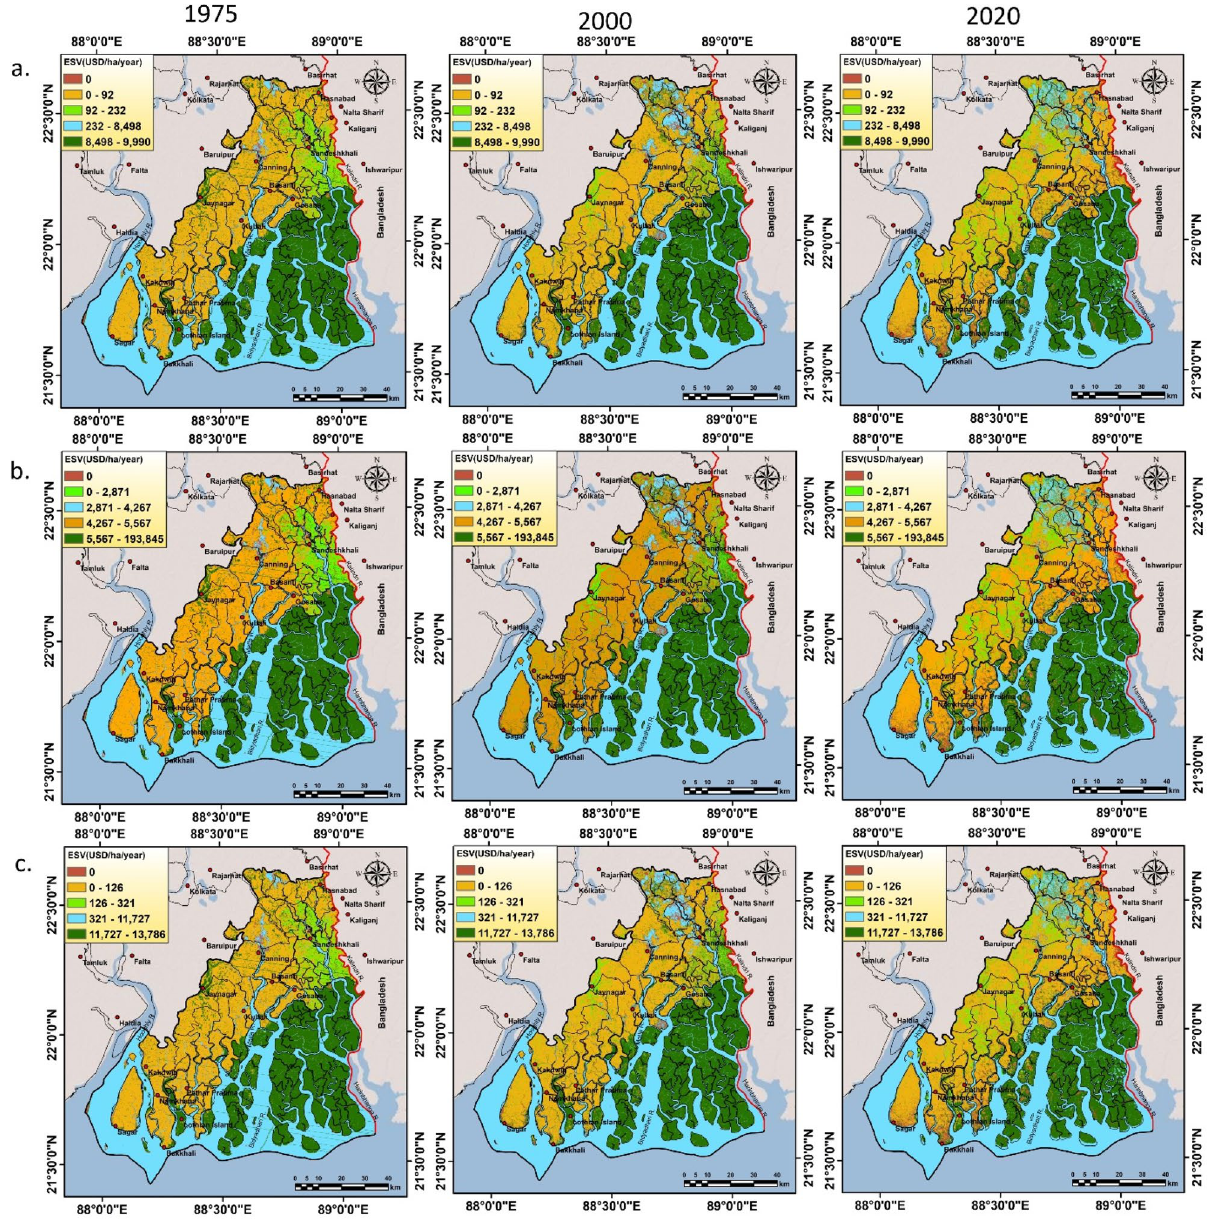
Figure 4. Spatial ordination of ecosystem service values (ESVs) (USD/ha/year) in 1975, 2000 and 2020 within the entire study region using ( a ). C97a ( b ). D12 ( c ). C97b unit values. The maps were prepared using ArcGIS 10.3 software [https:// deskt op. arcgis.